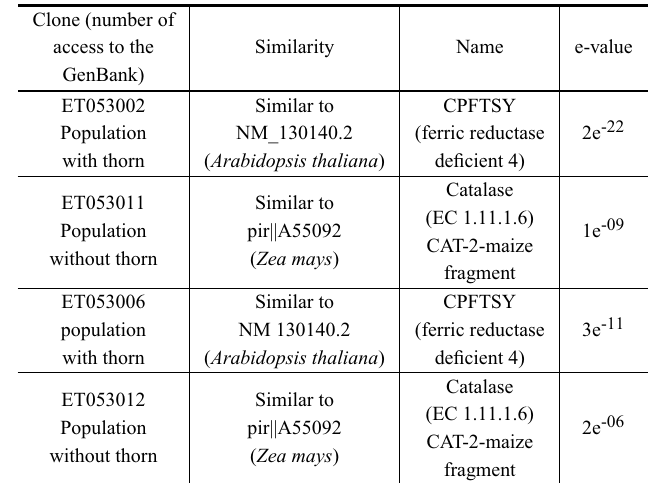
Analysis of Bioinformatics (BLASTx) of the selected clones, by RAPD, in Caryocar brasiliense (Camb.) with and without thorn at the